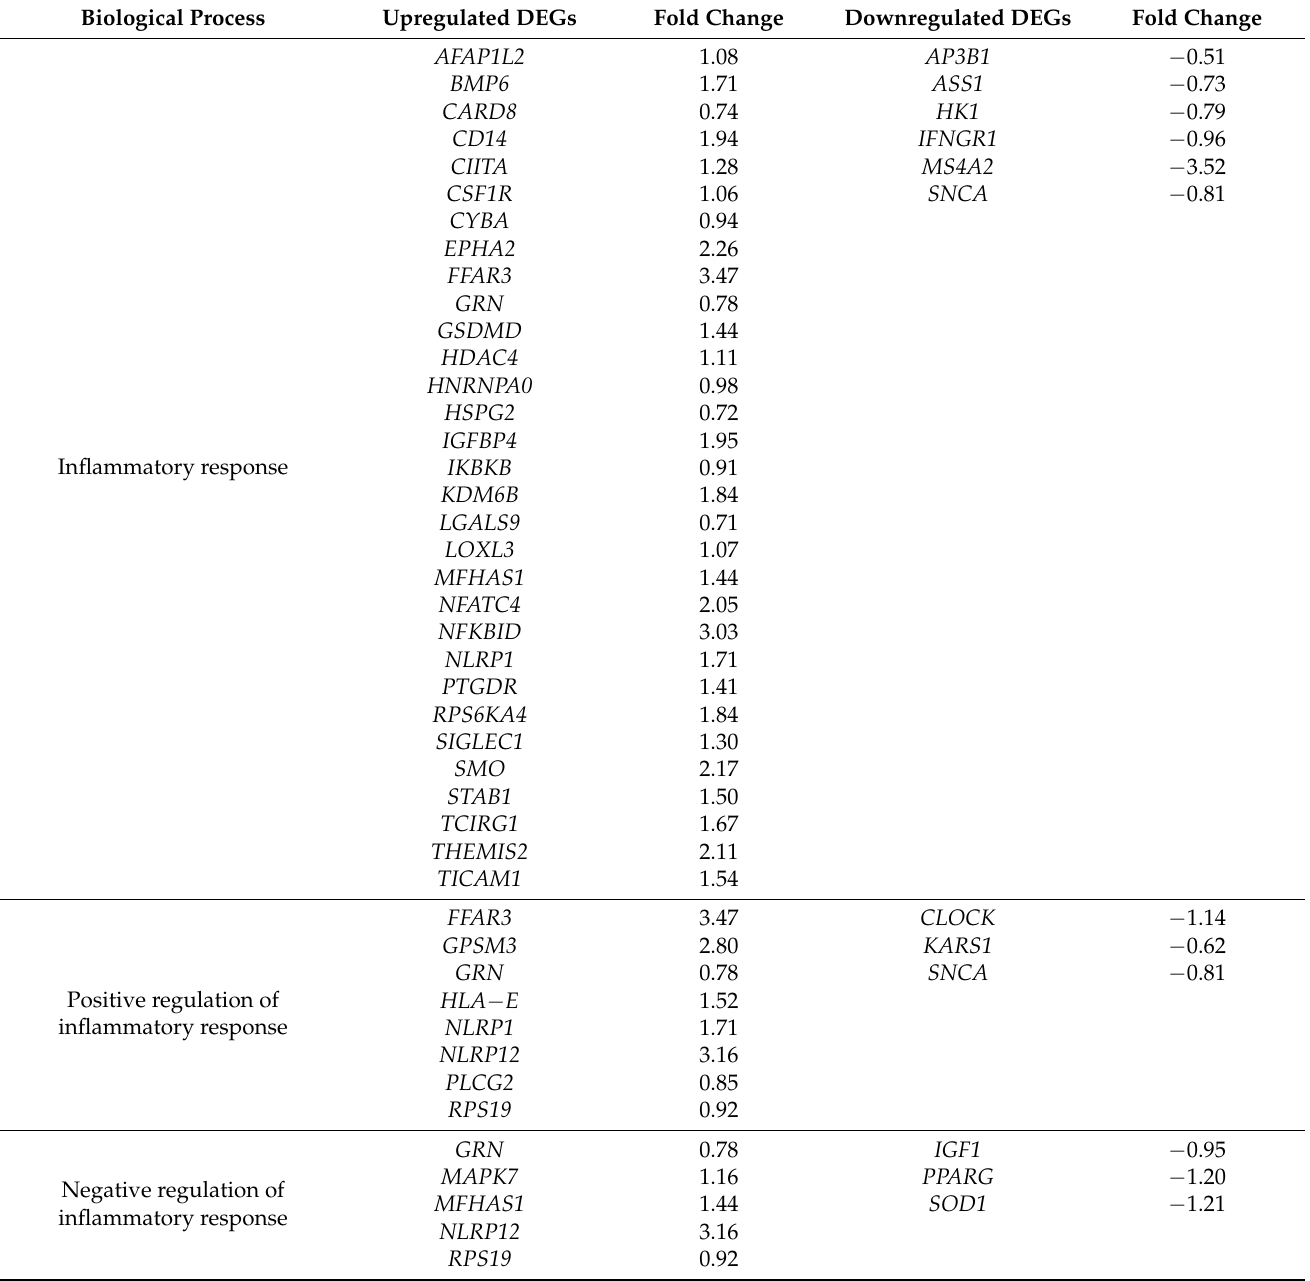
Table 4. Differentially expressed genes (DEGs) up and downregulated involved in the “Inflammatory response” and its